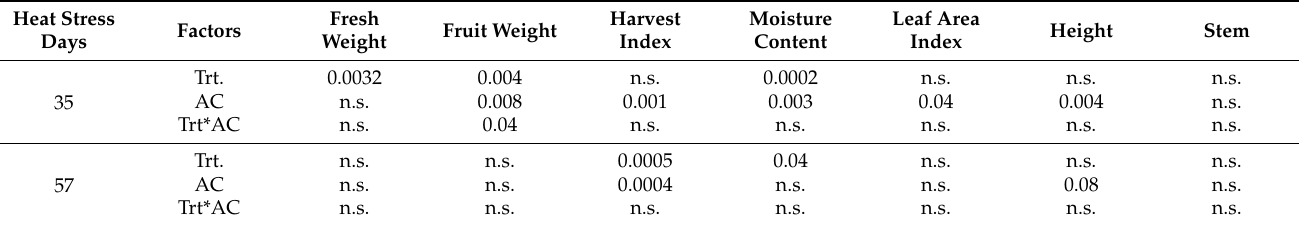
Table 2. ANOVA of the effects of heat treatment (Trt.), accession (AC), and their interactions (Trt*AC) on morphological characteristics at alpha = 0.05. n.s. data are not